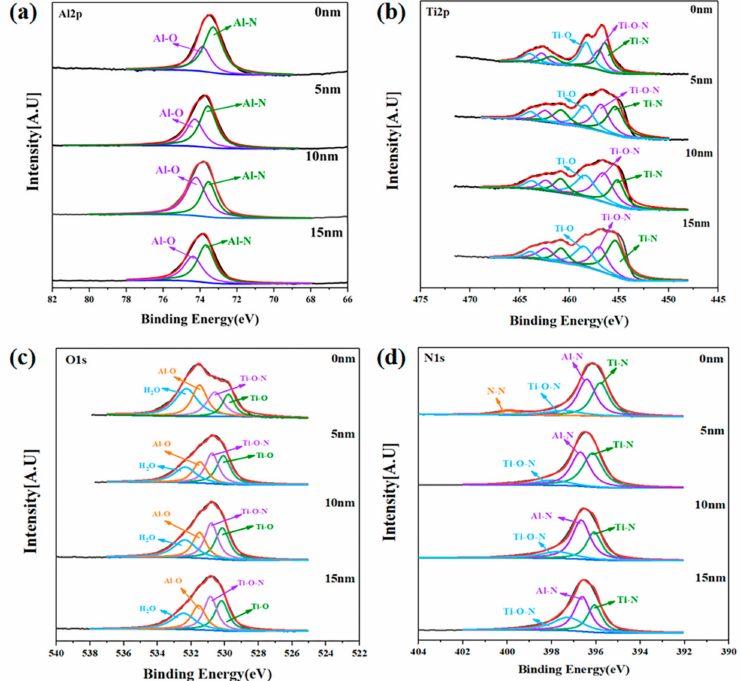
Figure 9. High-resolution XPS spectra of PVD-Ti 0.40 Al 0.60 N coating after immersion as a function of sputtering depth. ( a ) Al 2p; ( b ) Ti 2p; ( c ) O 1s; ( d ) N